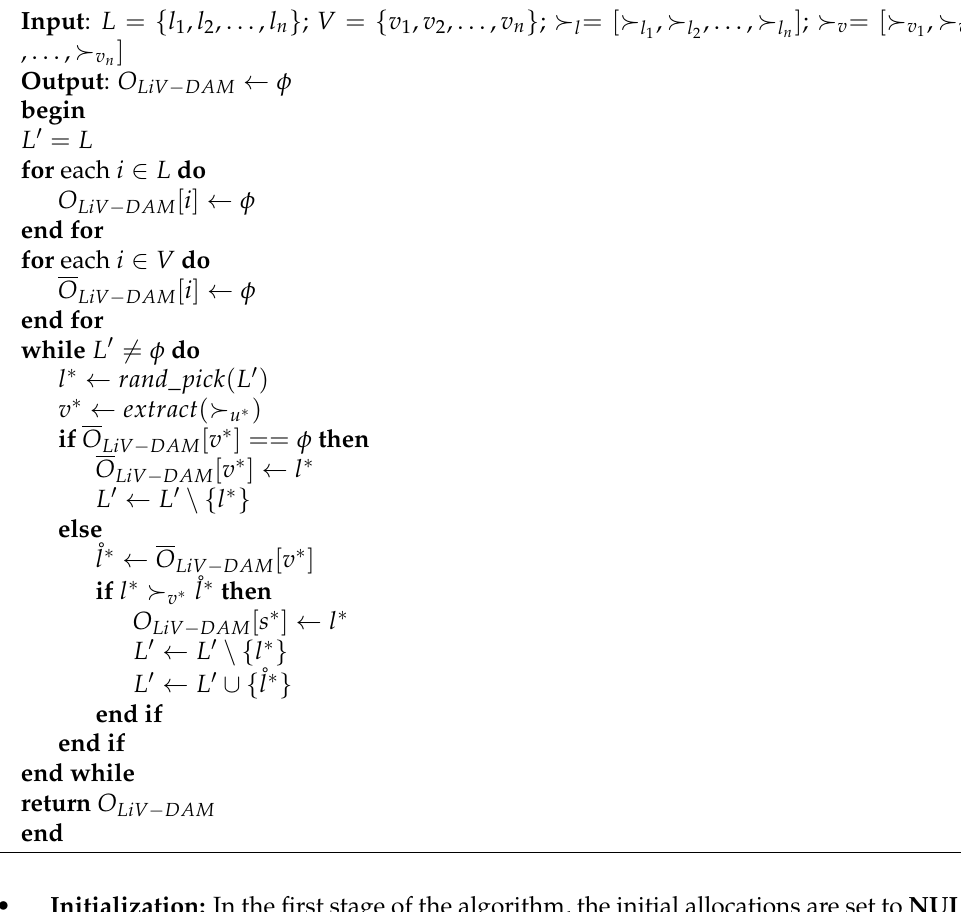
Algorithm 1 LiDAR-VSP Double Allocation Mechanism